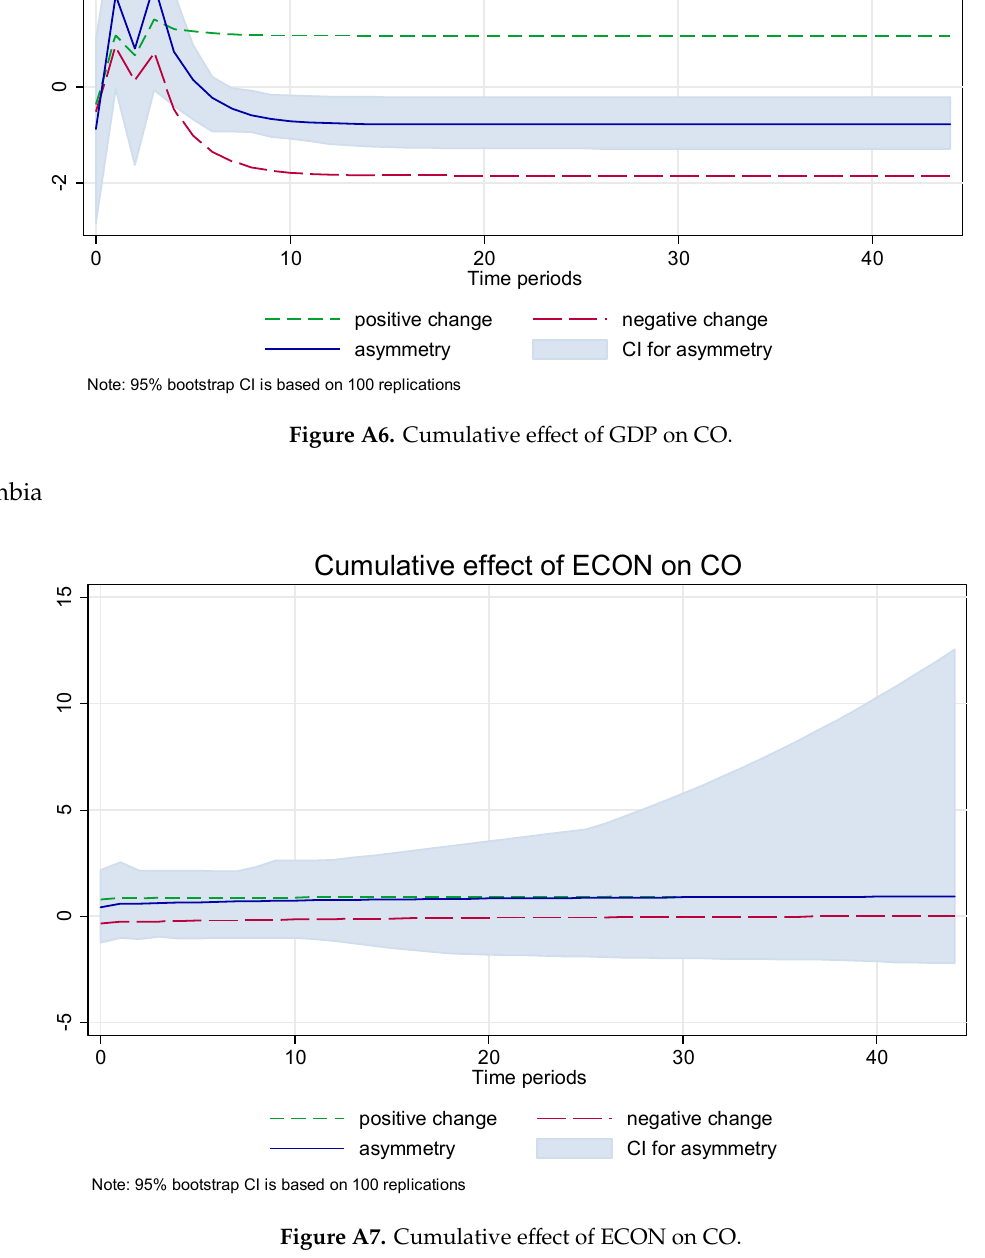
Figure A7. Cumulative e ff ect of ECON on Figure A7 . Cumulative effect of ECON on CO . Figure A7 . Cumulative effect of ECON on CO .